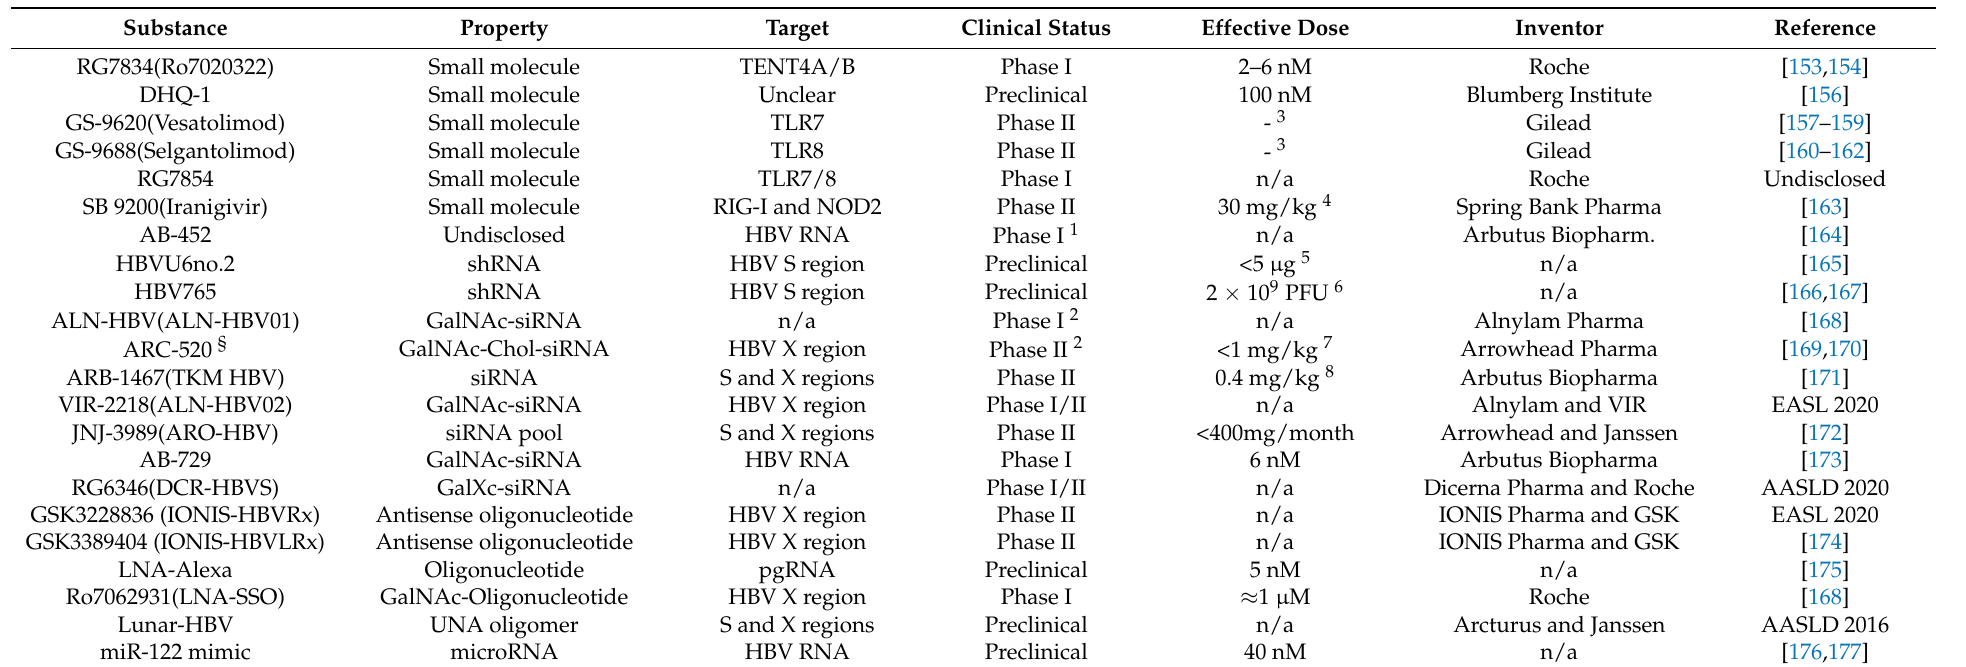
Table 2. Inhibitors targeting and silencing HBV